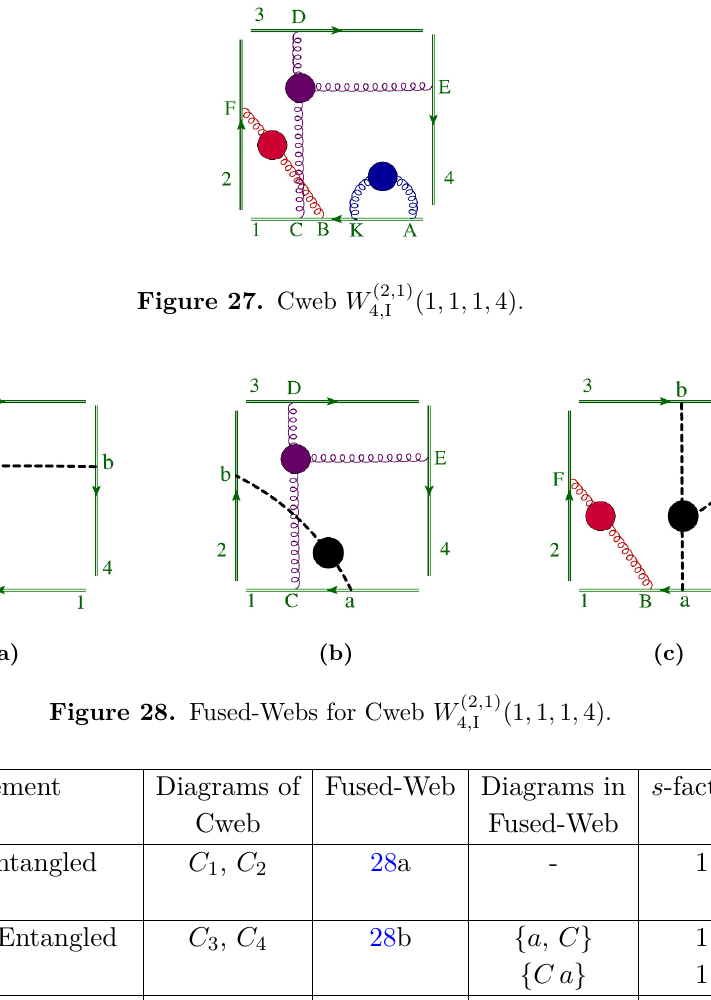
Table 16. Fused-Webs and their mixing matrices for Cweb W (2 , 1)